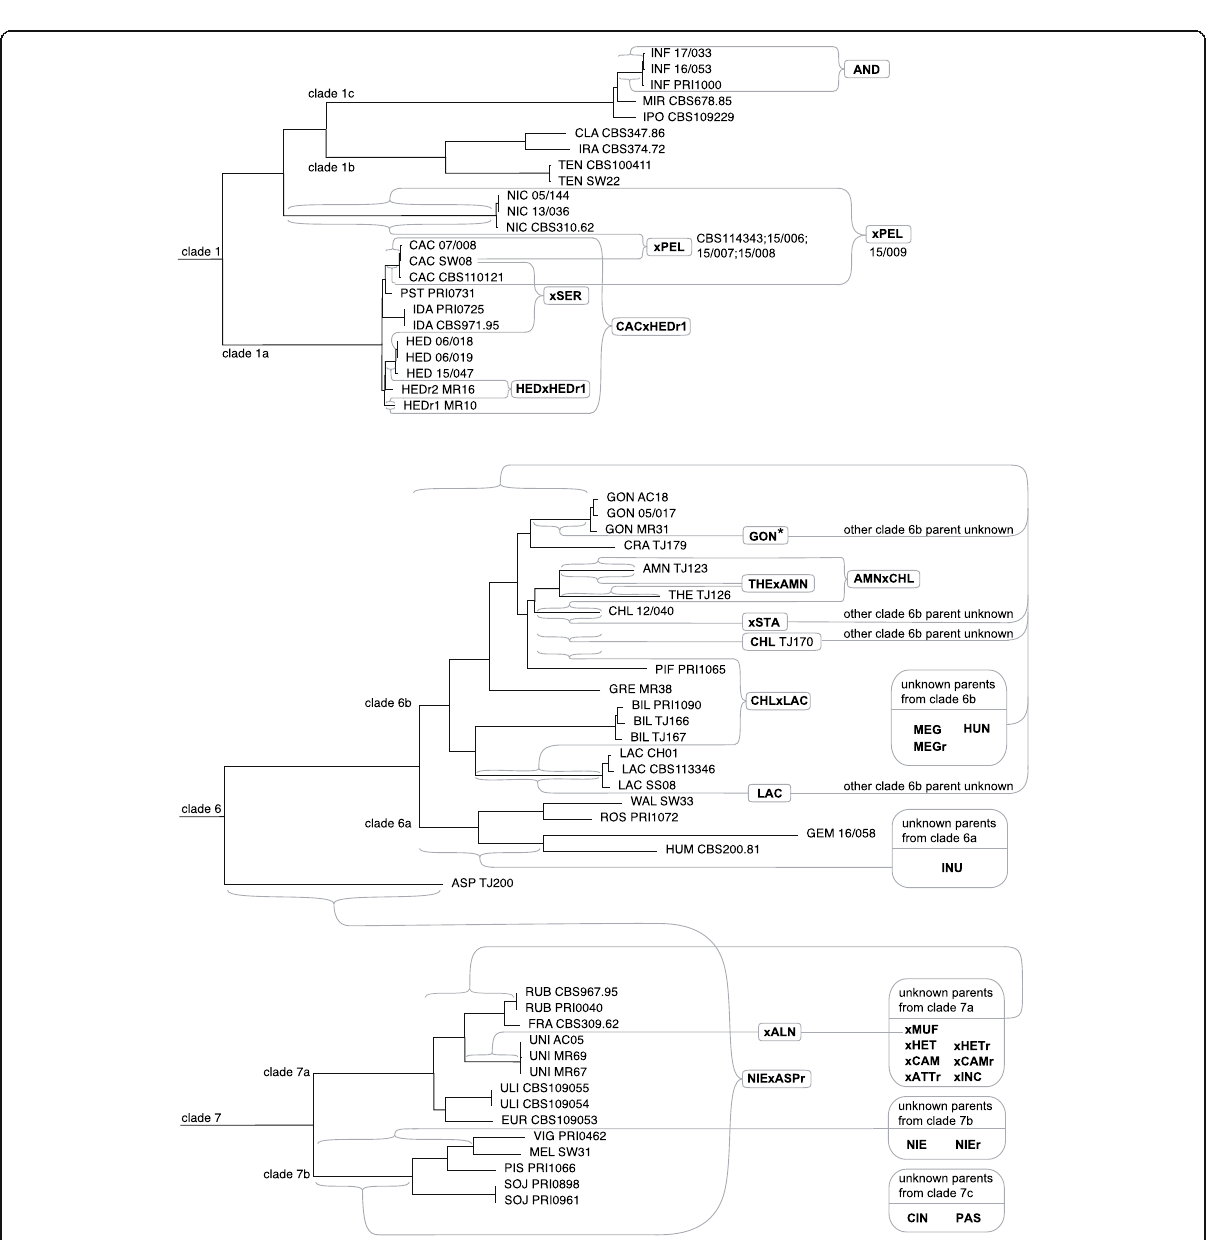
Fig. 5 Phylogenomic trees of Phytophthora clades 1, 6 and 7 (subtrees excerpted from Figure S6, which contains all species used for the phylogenomic analyses). Hybrids are indicated in bold, positioned separately and linked to their parental species. If a parental species is unknown, the accolade points to the longest branch of the subclade to which the parental species belongs. If the genotype of (one of) the parental species is unknown, accolades are placed at the branch in which the parental species reside. The P. gonapodyides hybrids indicated with an asterisk refer to isolates 05/003, 05/020, 05/025, 06/002, 07/004, 07/007, 08/001, CBS114340, MR30, MR37, SS07 and